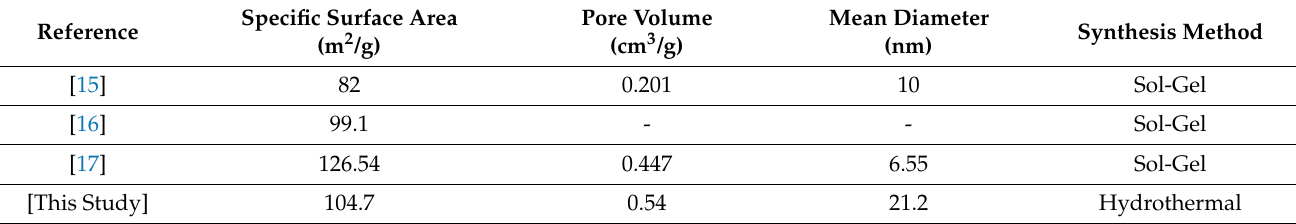
Table 2. Textural properties of synthetic bioactive